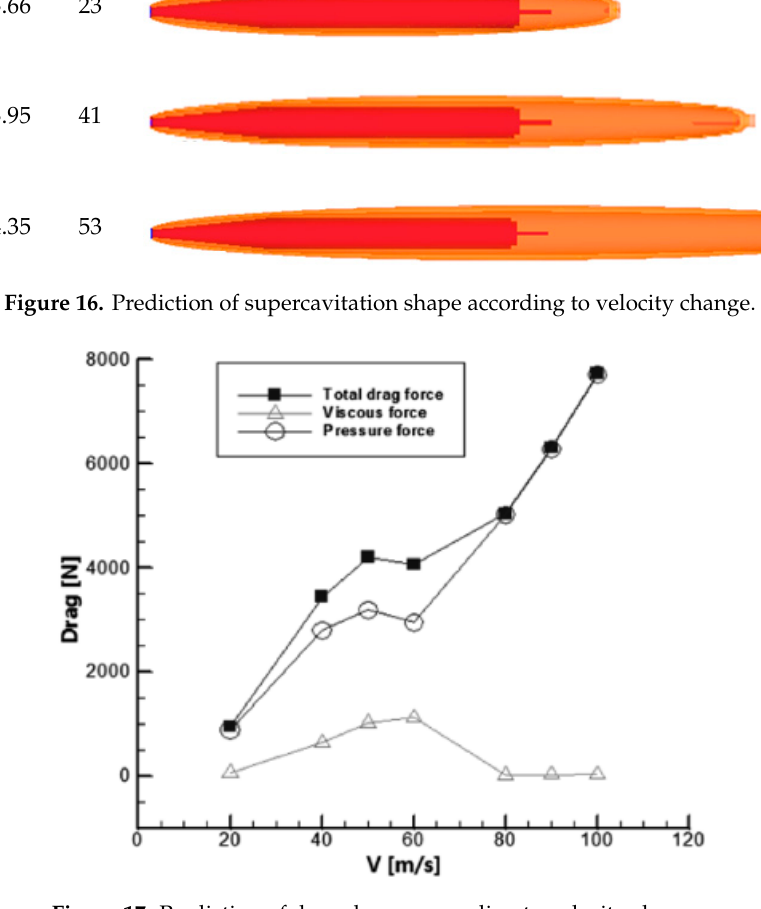
Figure 18. Analysis of drag unsteady state pressure force and viscous force at 50 m/s.